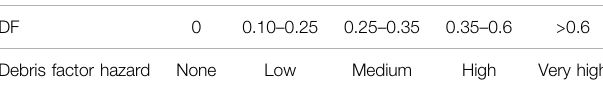
TABLE 4 | Classi fi cation of debris factor hazard class.